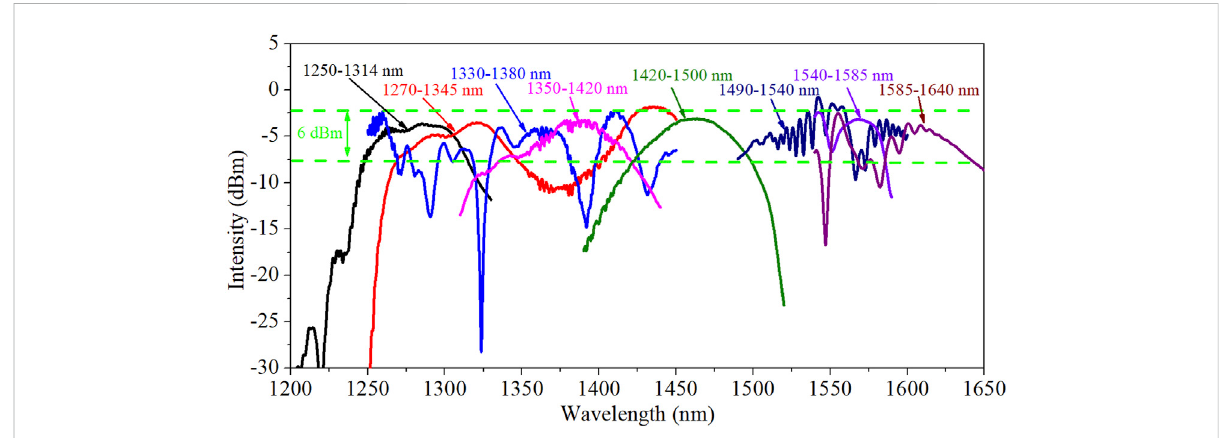
FIGURE 4 Extended spectrum for the dispersion measurement of a microcavity.